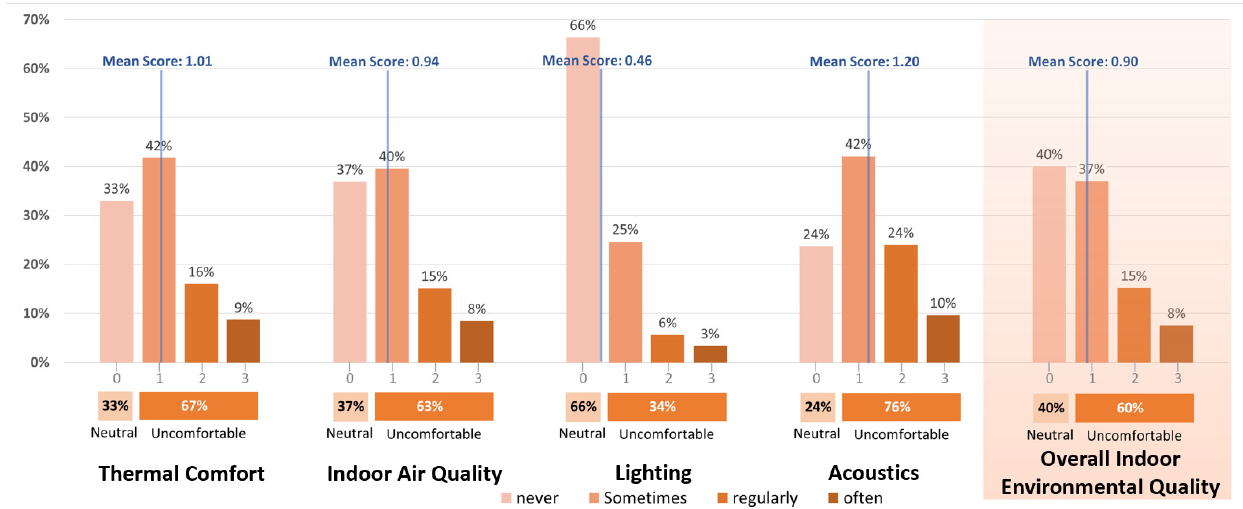
Figure 7. Distribution of votes corresponding to the different factors of IEQ as expressed by building occupants in questionnaire surveys.